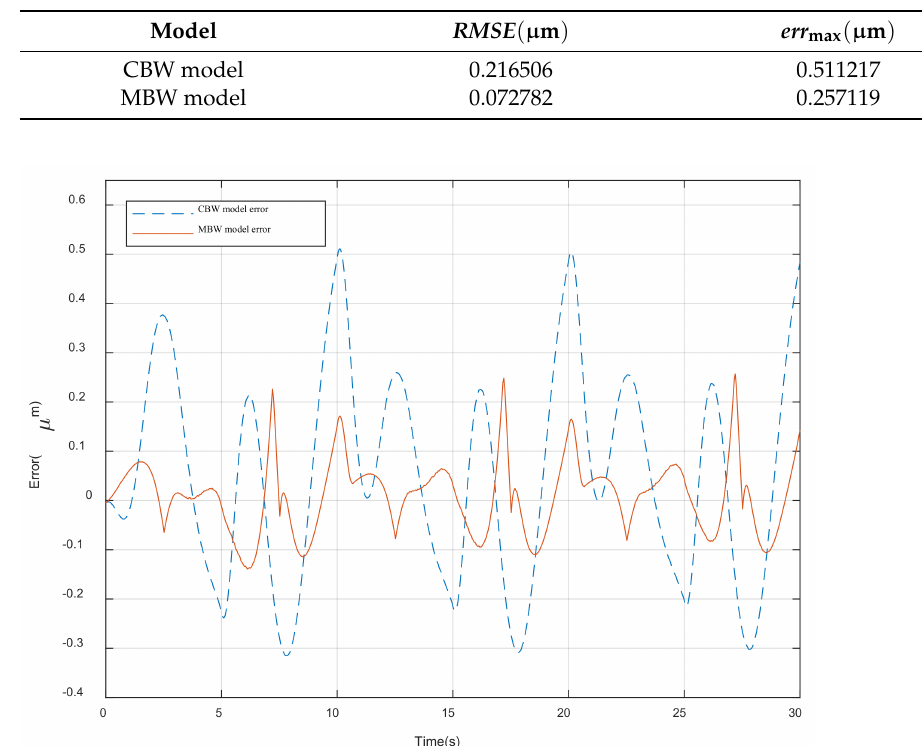
Figure 9. Modeling error of MBW model.